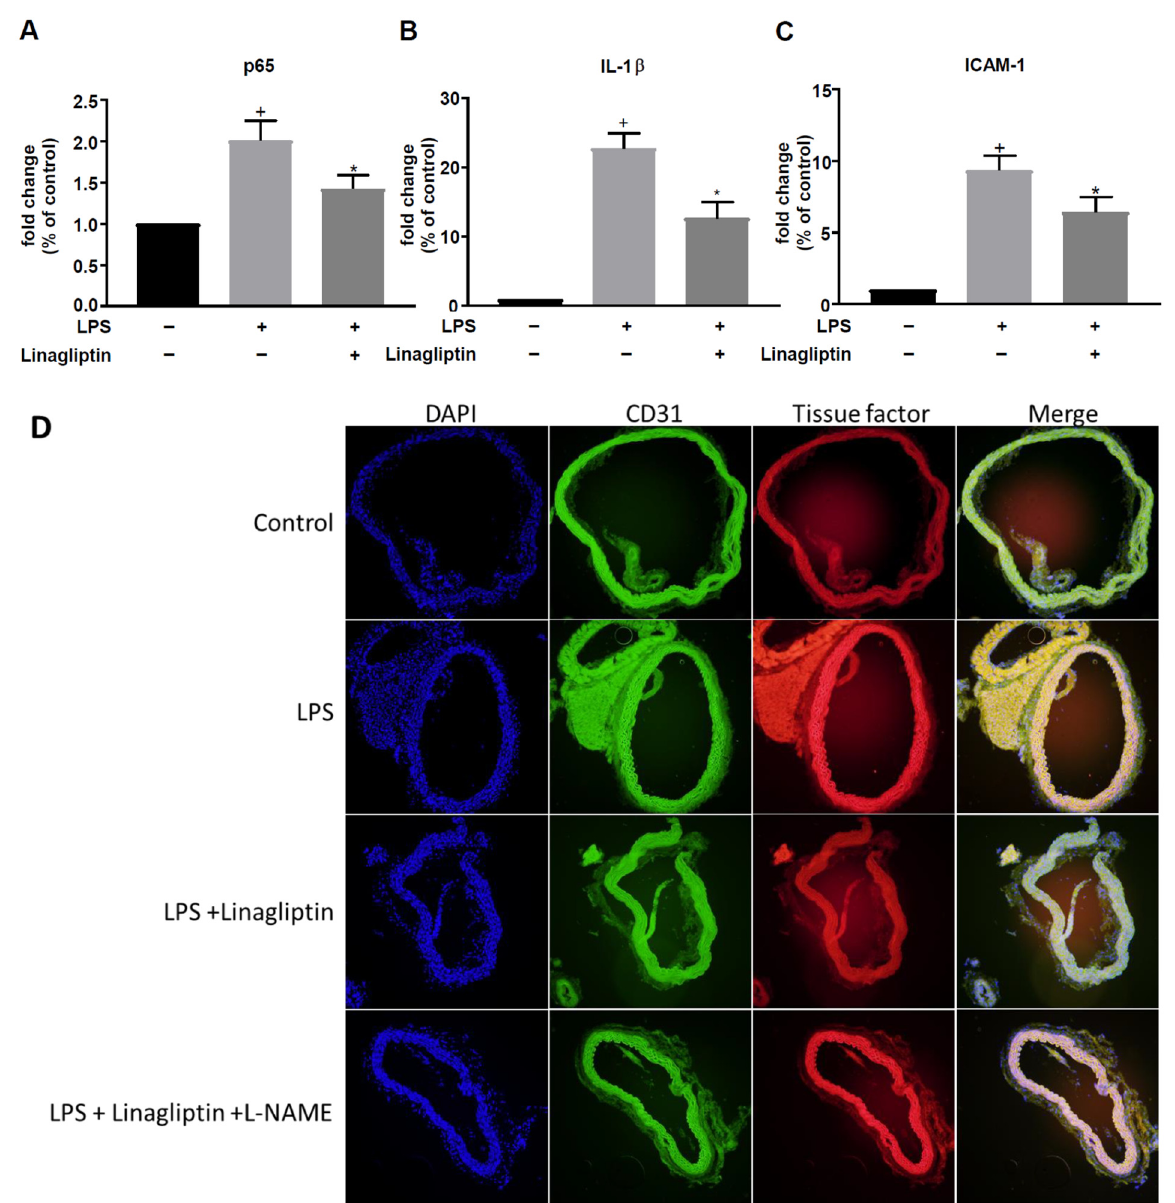
Figure 3. Linagliptin attenuated the LPS-induced expression of inflammatory cytokines in vivo . The aortic tissues of LPS-injected mice with or without linagliptin treatment were isolated to measure the fold change in gene expression of ( A ) p65, ( B ) IL-1 β , and ( C ) ICAM-1 by qPCR. ( D ) Immunoflu- orescence stain of CD-31 and TF in cross-sections of mouse aorta. n = 7 in each group. + p ≤ 0.05 compared to untreated controls. * p ≤ 0.05 compared to LPS-treated mice.